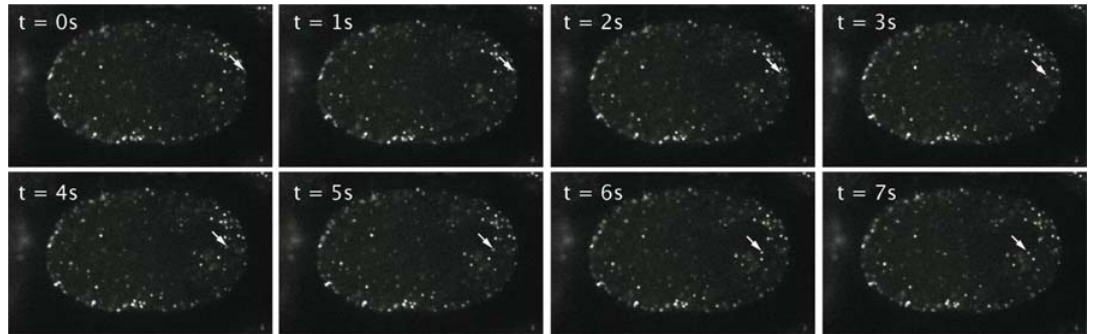
Figure 5. Centrosome directed movement of EEs. EEs visualied live using GFP:EEA-1(FYVE*2). Shown are eight still images taken 1 second apart; arrow points to an EE that moves rapidly towards the